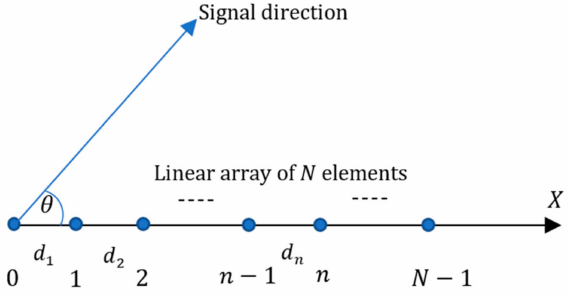
Figure 1. Convergence behavior of the SSD and SSR algorithms with the number of SLL reduction